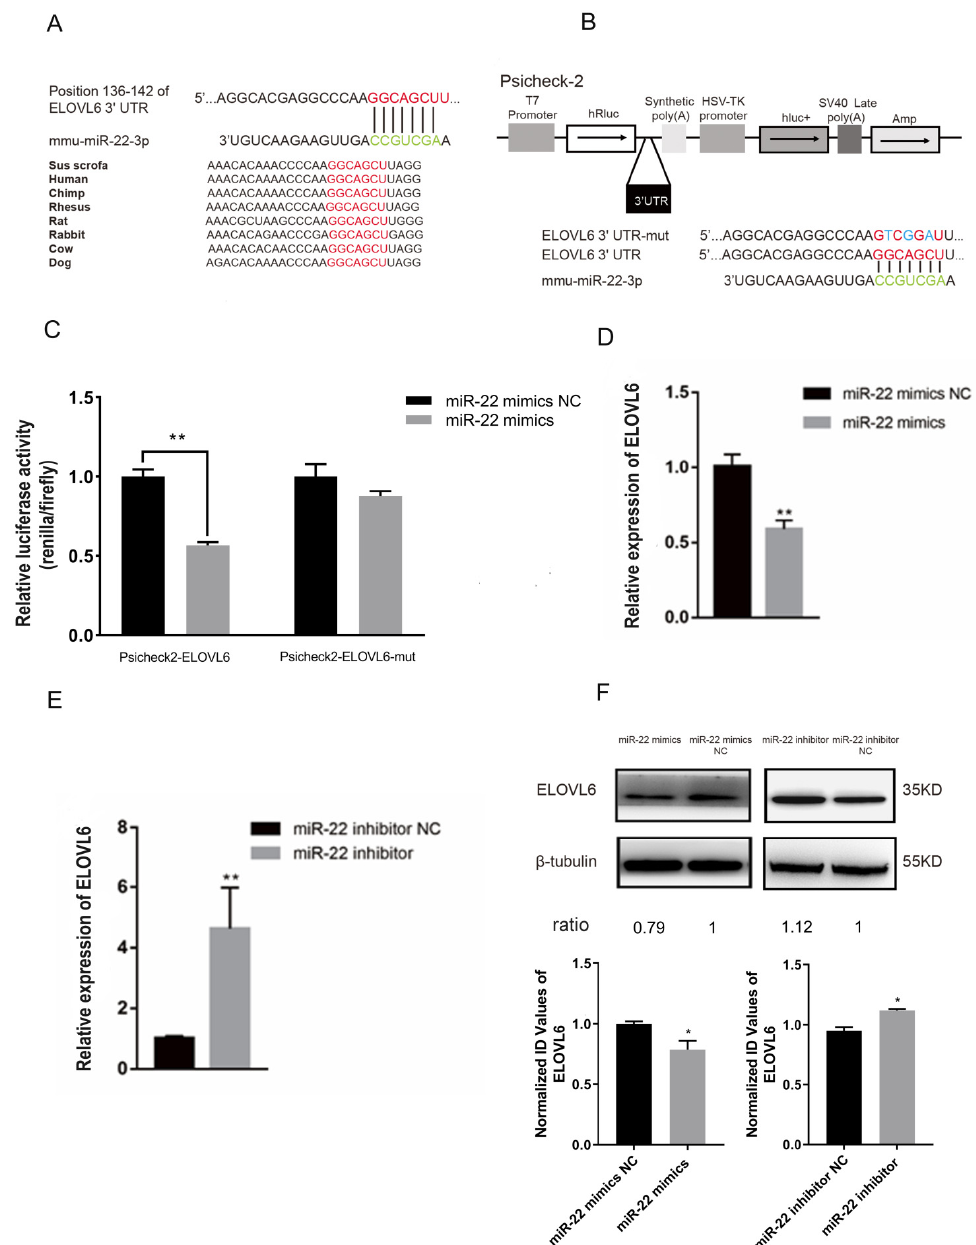
Figure 3. Elongation of long-chain fatty acids family member 6 (ELOVL6) is a target gene of miRNA-22. ( A ) The sequence of miR-22 and its predicted conserved binding region in ELOVL6 3 (cid:48) UTR (red). ( B ) Structure diagram of dual-luciferase reporter vector Psicheck-2. The predicted miR-22 target site of the ELOVL6 3 (cid:48) UTR and mutation target site were inserted into the 3 (cid:48) end of the Renilla luciferase gene (hRluc). The expression of firefly luciferase gene (hluc+) was used as the standard control. ( C ) C2C12 and HEK293T cells transfected with miR-22 mimics or NC were co-transfected with the Psicheck-2 ELOVL6 or Psicheck-2 ELOVL6-mut vector. Relative luciferase activity was determined after 24 h. ( D ) The expression of ELOVL6 mRNA in C2C12 cells following transfection of miR-22 mimics or negative control (NC). ( E ) The expression of ELOVL6 mRNA in C2C12 cells following transfection of miR-22 inhibitor or inhibitor NC. ( F ) The protein expression of ELOVL6 following transfection with miR-22 mimics, NC, miR-22 inhibitor, or inhibitor NC for 24 h was detected by Western blotting. Ratios represent the densitometry value of the treatment group compared to the control group. * p < 0.05, ** p < 0.01. Data represent mean ± SEM from at least three independent